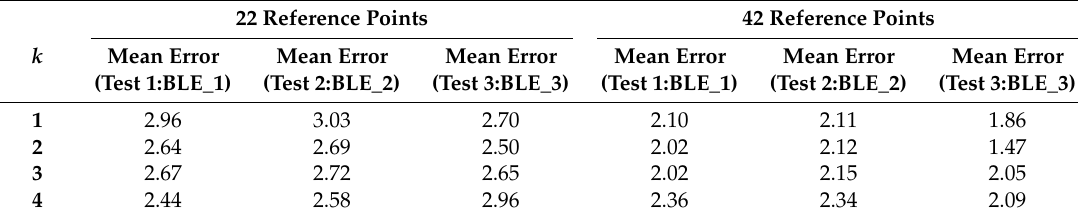
Table 7. Precision of Tests 1, 2 and 3. 22 reference points.